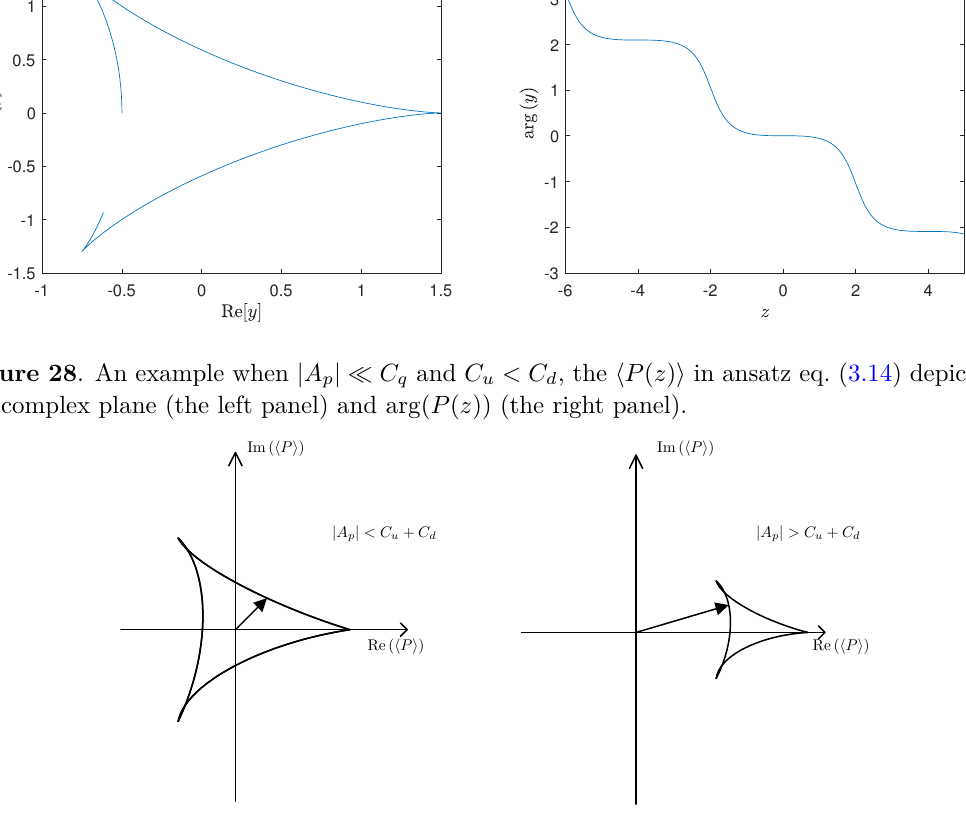
Figure 29 . The difference patterns of the phase of the Polyakov loop when | A p | < C u + C d (the left panel) and | A + C (the right p | > C u d